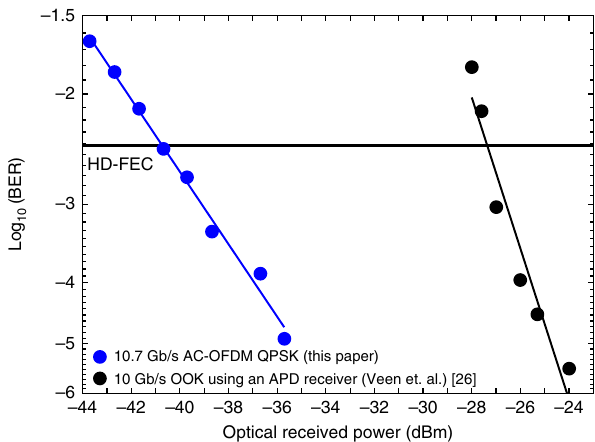
Fig. 7 Achievable split ratios with respect to transmission distance. Channel #2, offering the lowest power budgets of 44.5 and 38.5 dB for the Alamouti-coded OFDM QPSK and 16-QAM, respectively, is considered in this analysis. Loss per splitter and average fi bre attenuation are assumed to be 3.5 and 0.26dB/km, respectively. The experimental demonstrations are shown by the blue and green markers . Note that the margins of 2.6 and 0.5 dB correspond to the sensitivity margins. An extrapolation analysis for the NG-PON2 (with a power budget of 31 and 32.5 dB) is also shown in the plot. The NG-PON2 marker corresponds to 1:64-way power split (allowing 64 subscribers) at a transmission distance of 40 km